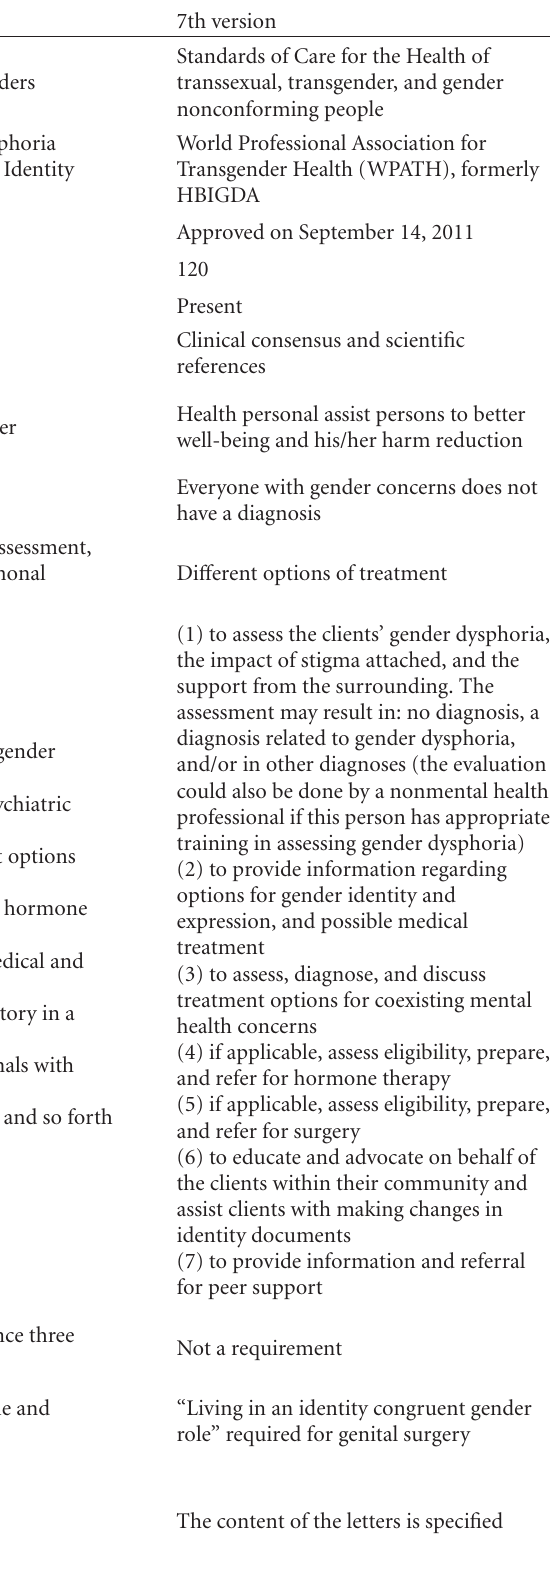
Table 2: Di ff erences between the 6th [20] and the 7th [17] versions of the Standards of